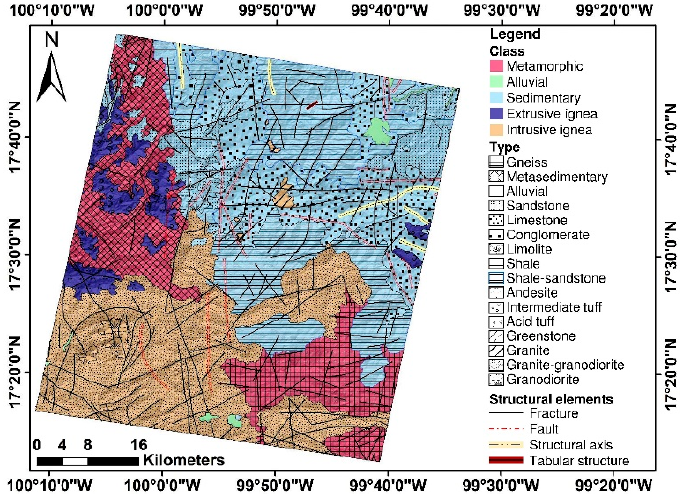
Figure 2. Geological map of study area.